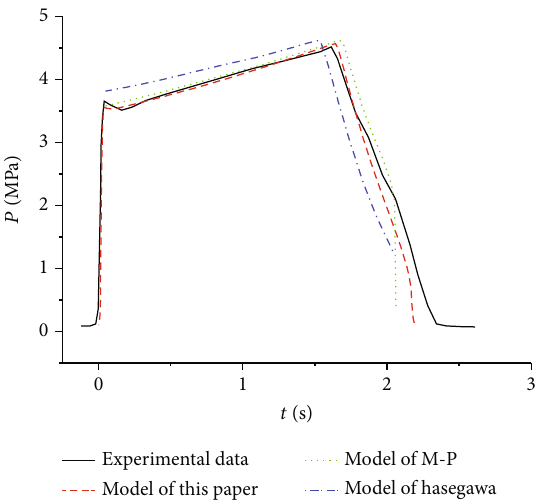
Figure 10: Pressure history of motor A.